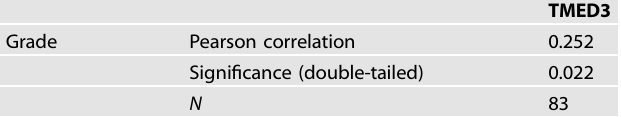
Knockdown of TMED3 inhibits the progression of LUSC in vitro